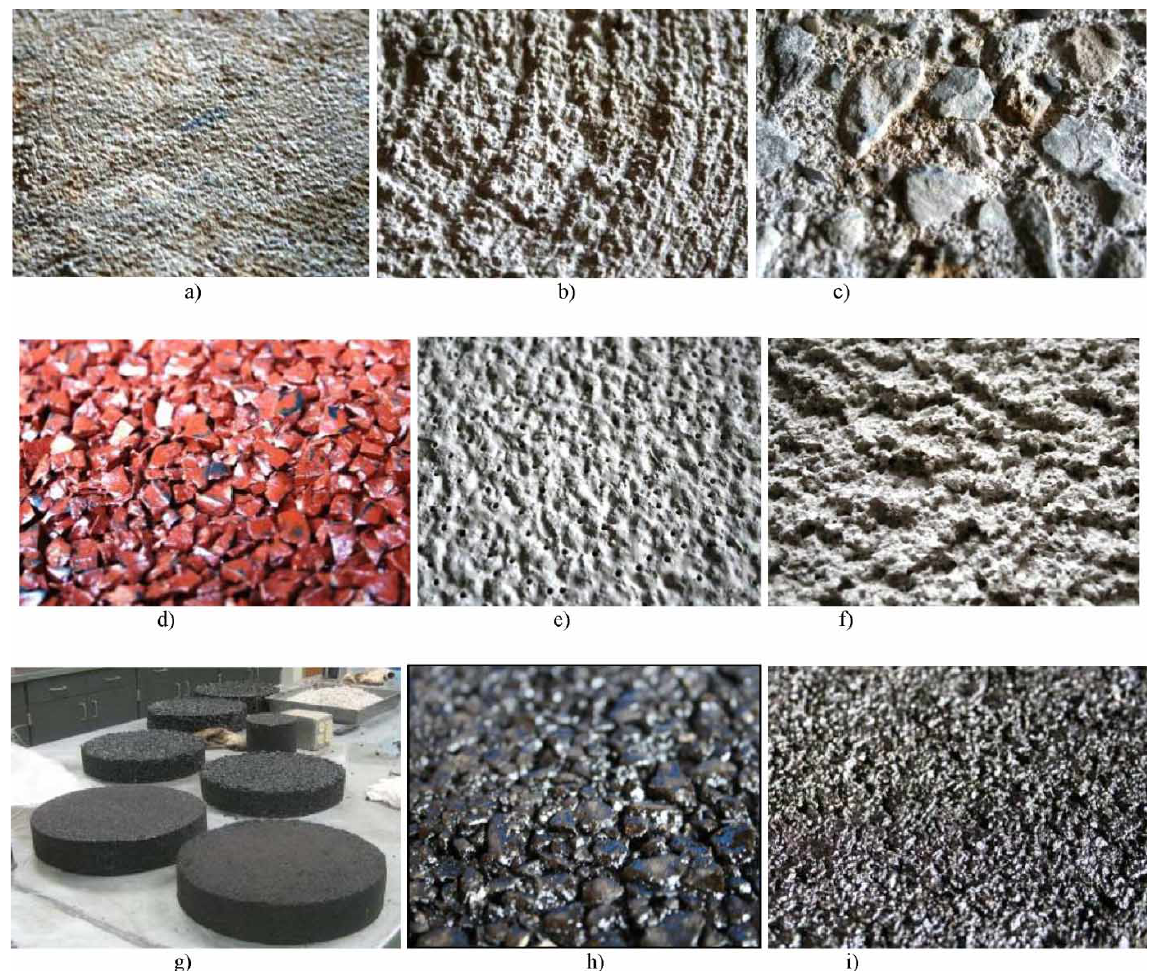
Fig. 2. Selected samples and surface texture: (a) burlap layover Portland cement concrete; (b) burlap drag concrete; (c) exposed aggregate concrete; (d) rubber stepping stone; (e) Alpine panel; (f) Cheyenne tile; (g) 356 mm diameter